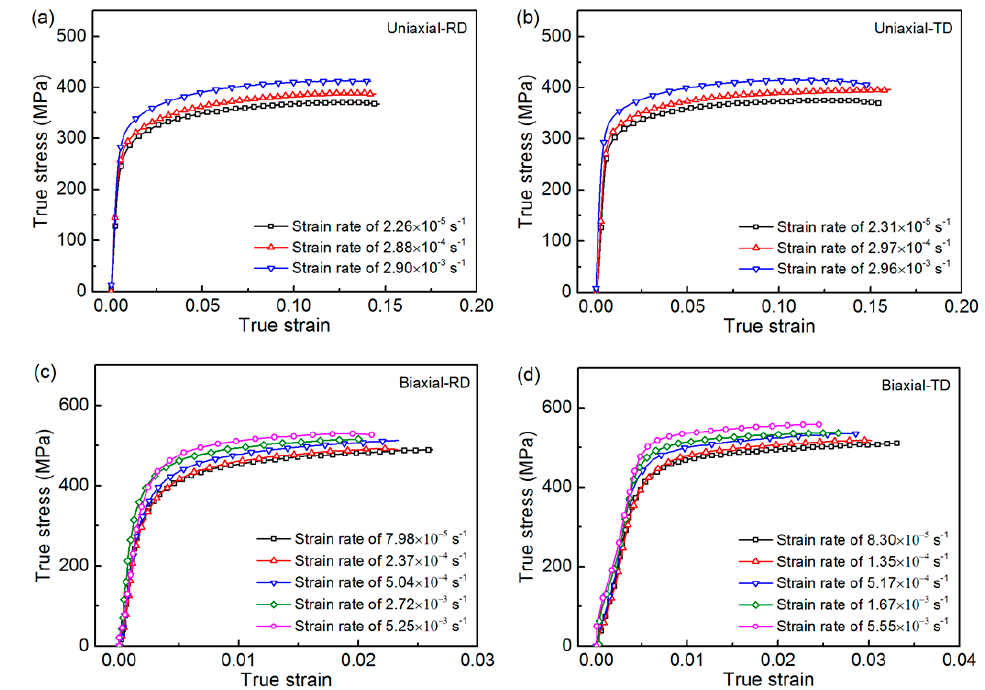
Figure 10. True stress-strain curve of CP-Ti at various strain rates: ( a ) uniaxial RD, ( b ) uniaxial TD, ( c ) biaxial RD, ( d ) biaxial TD.